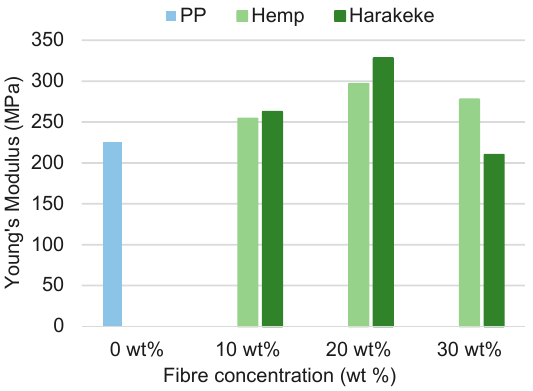
Figure 12. Young’s modulus of FDM printed dog bone specimens versus fibre content (in wt %). Filament and dog bone samples demonstrated a clear transition from ductile to brittle failure mode, starting at both 10 wt % hemp and harakeke with failure strain generally reducing with increasing fiber content and similar behavior for both hemp and harakeke fiber (see Table 1) . Typical stress versus strain graphs are shown in Figure 13.